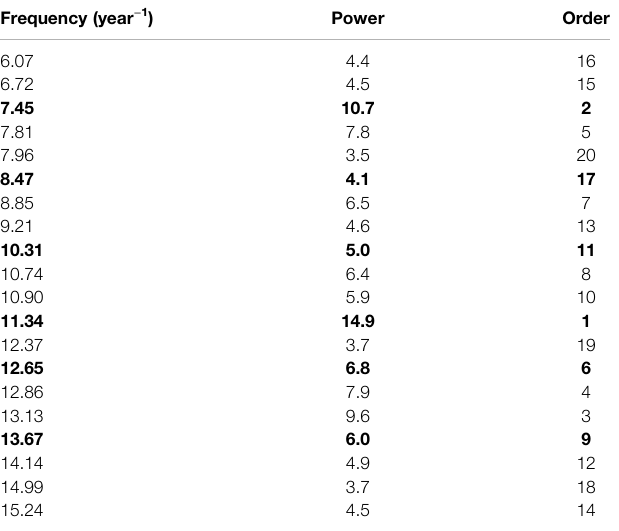
TABLE 3| Top20peaksinthepowerspectrumformedfrom GSInoon datainthe frequency band 6 – 16 years − 1 . Entries in bold comprise a triplet and two doubletswithfrequencyseparationscloseto1year − 1 :7.45,8.45and9.45year − 1 ; 11.35 and 12.35 year − 1 ; and 12.65 and 13.65 year − 1 .